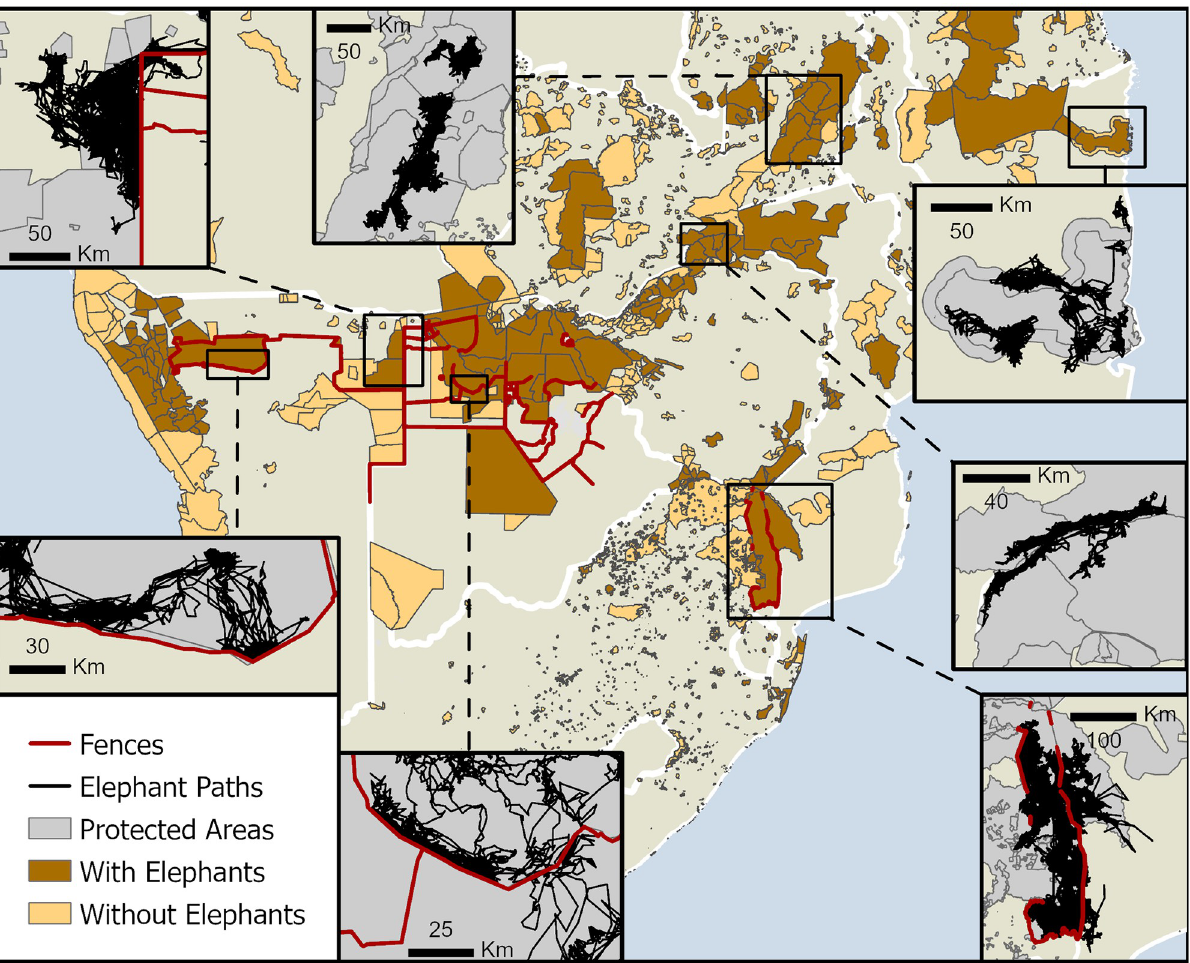
Fig 3. Map of fences. Fences (red) and elephant paths (lines between consecutive telemetry points) (black) across southern Africa. Protected areas (grey in inset maps) with elephants (dark brown) or without (light brown) appear on the large map.